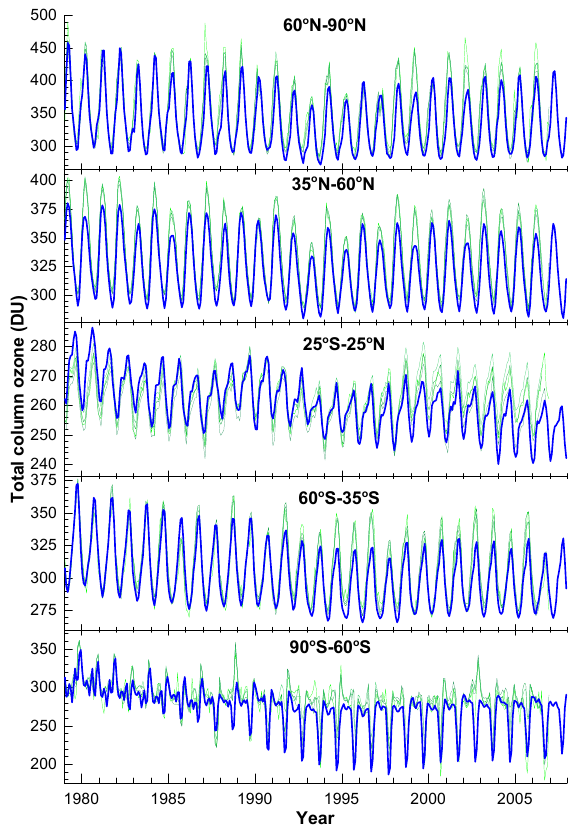
Figure 10. A comparison of zonal mean total column ozone from the four monthly mean observational time series updated from Fioletov et al. (2002) shown in green traces, and zonal mean total column ozone calculated by vertically integrating the Tier 1.4 database (blue trace). It is not necessary to distinguish between the four independent total column ozone time series and so these are not labeled individually.